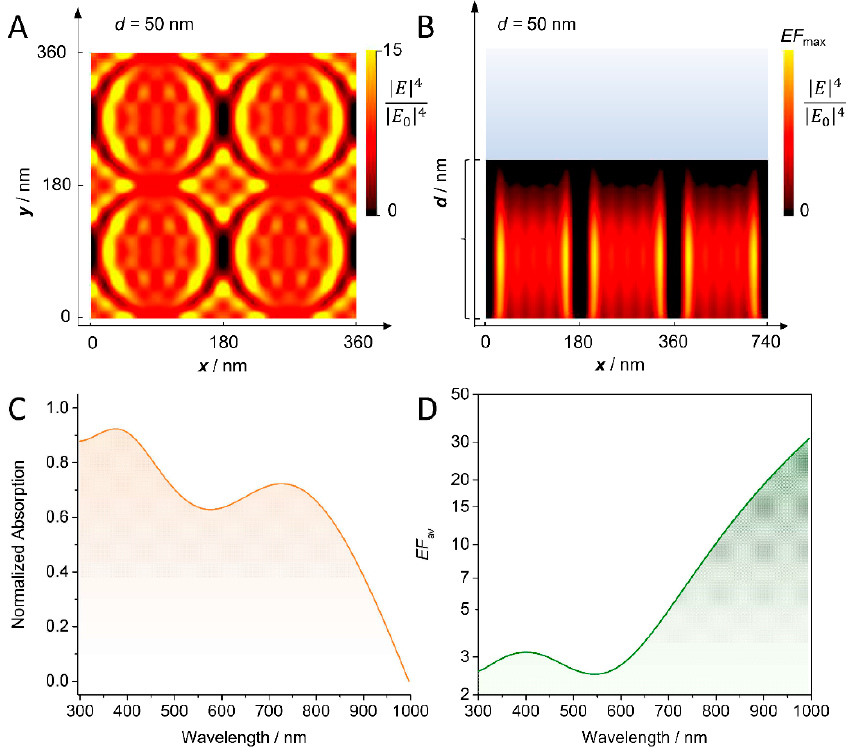
Figure 4. ( A ) Top view over 4 unit cells and ( B ) side view over 3 unit cells showing the distribution of localized field hot spots upon illumination at 413 nm for a nanotube length d = 50 nm. The scale shows the field enhancement (EF) value to fourth order 𝐴 = 1 − 𝑅 − 𝑇 averaged over all considered nanotube lengths. ( D ) Calculated EFs over all considered nanotube lengths.